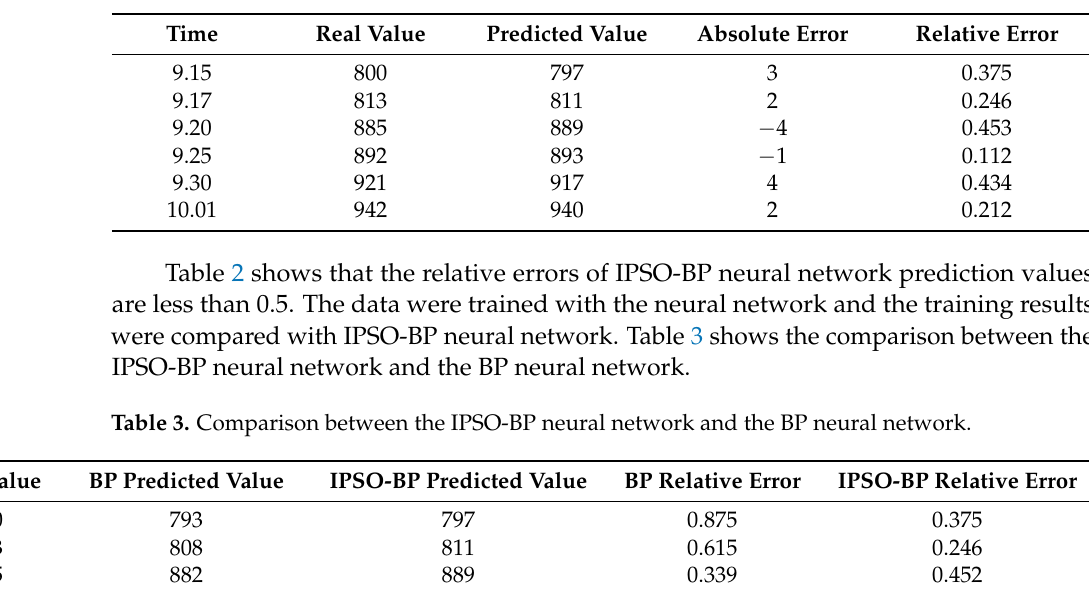
Table 2. IPSO-BP neural network training table.